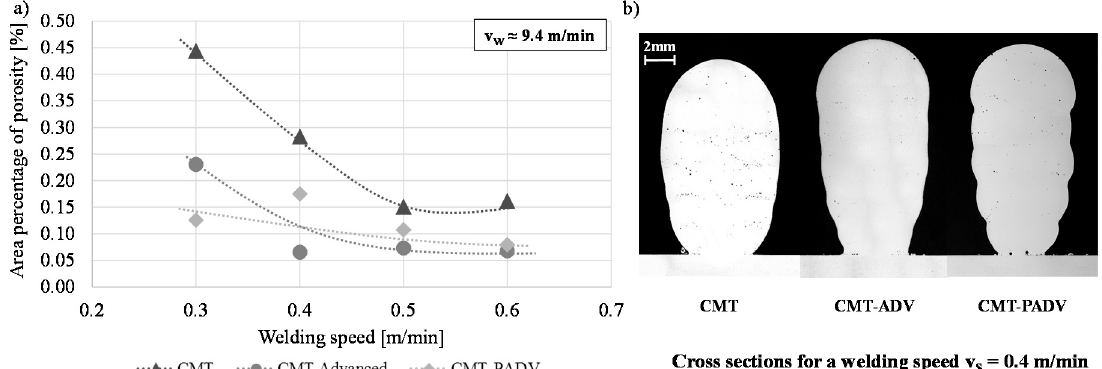
Figure 7. ( a ) Correlation of the porosity and the welding speed for the arc modes CMT, CMT-ADV and CMT-PADV with a wire-feed speed of approx. v w = 9.4 m/min and ( b ) the optically observed porosity in the cross-sections of the five-layer wall structures for the different arc modes at a welding speed of v S = 0.4 m/min.